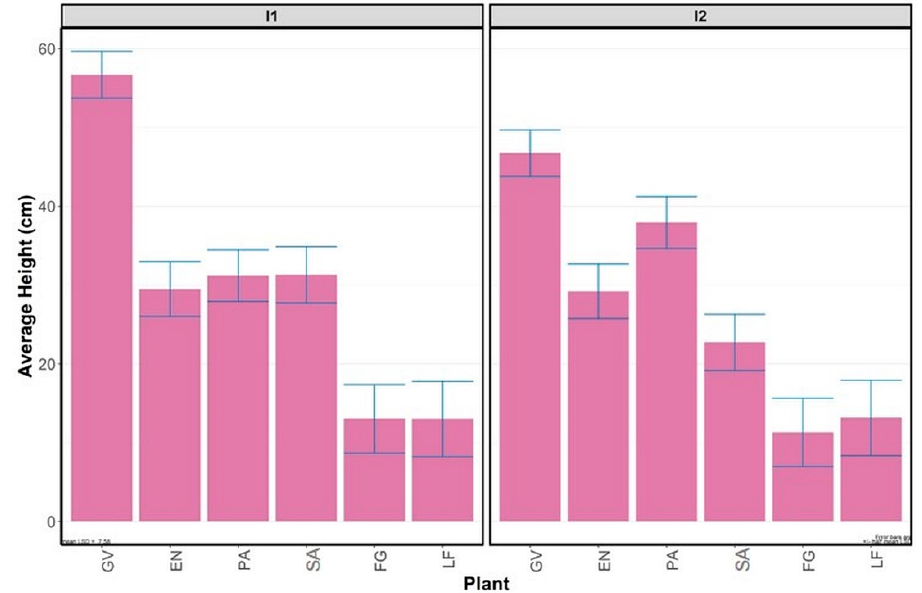
Figure 6. Predictions of H (cid:2911)(cid:2932)(cid:2917) for plants in different irrigation treatments. Error bars are approximately ±0.5 LSD (5%); if they do not overlap, the predicted means are significantly different ( p ≤ 0.05), while those whose error bars overlap are not significantly different ( p > 0.05).